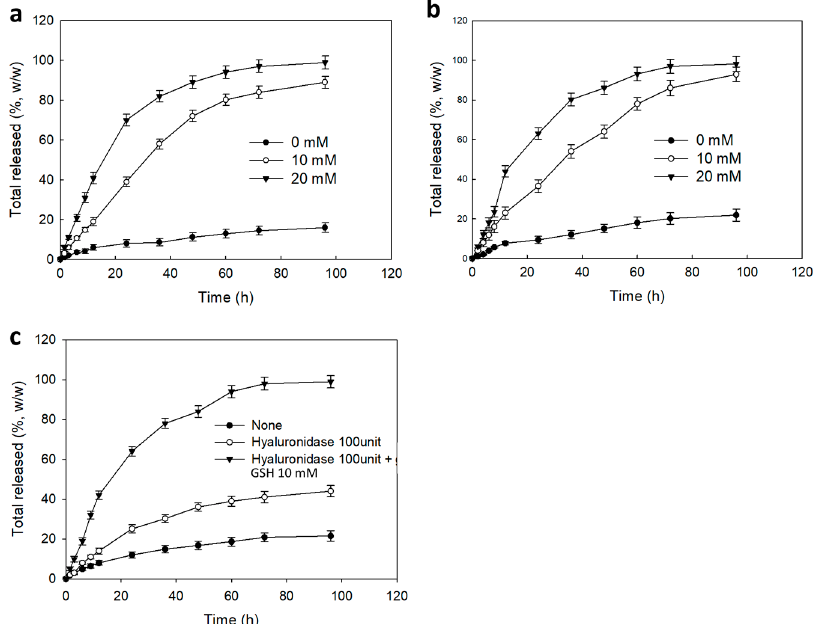
Figure 5. The effect of DTT on the Ce6 release dynamics from Ce6tetraHA ( a ) and Ce6decaHA ( b ) nanophotosensitizers. ( c ) The effect of HAse/DTT on the Ce6 release dynamics from Ce6tetraHA nanophotosensitizers. All the values are average ± S.D. from three different experiments.